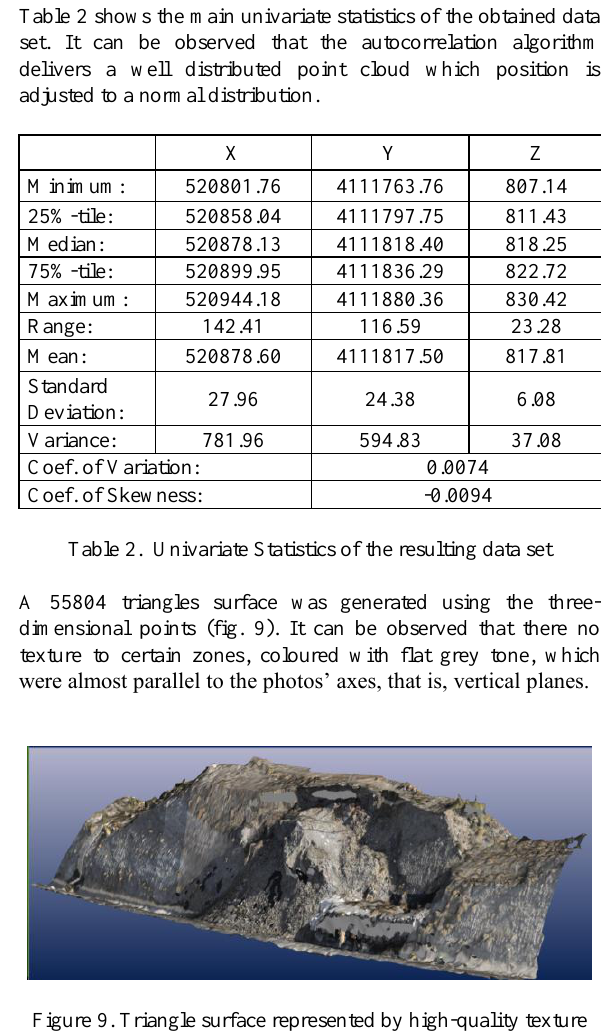
Figure 9. Triangle surface represented by high-quality texture mode